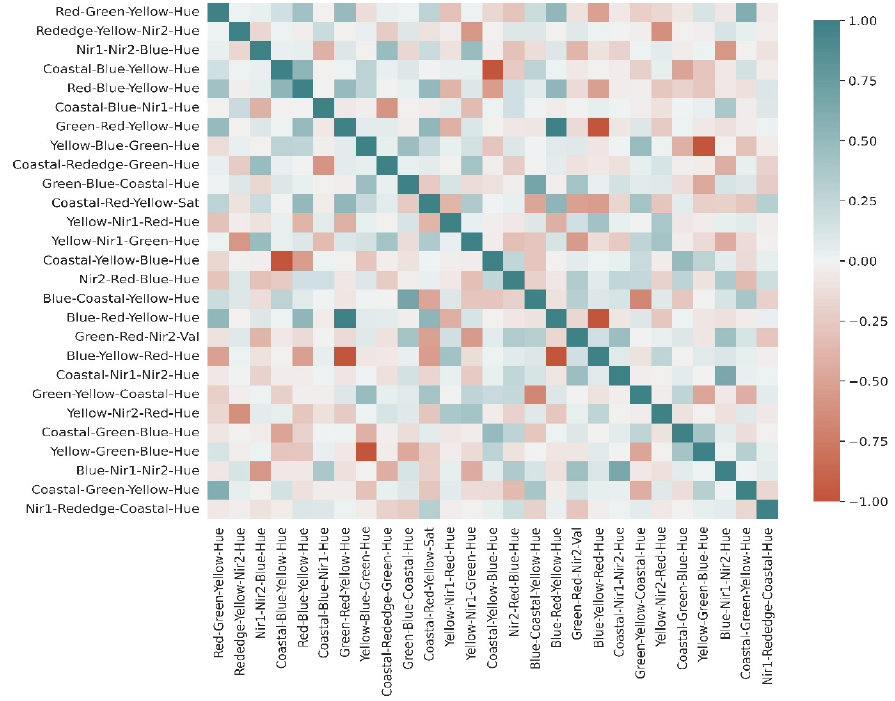
Figure 3. Correlation matrix plot of the 27 least-correlated HSV features generated from the multi- spectral image.